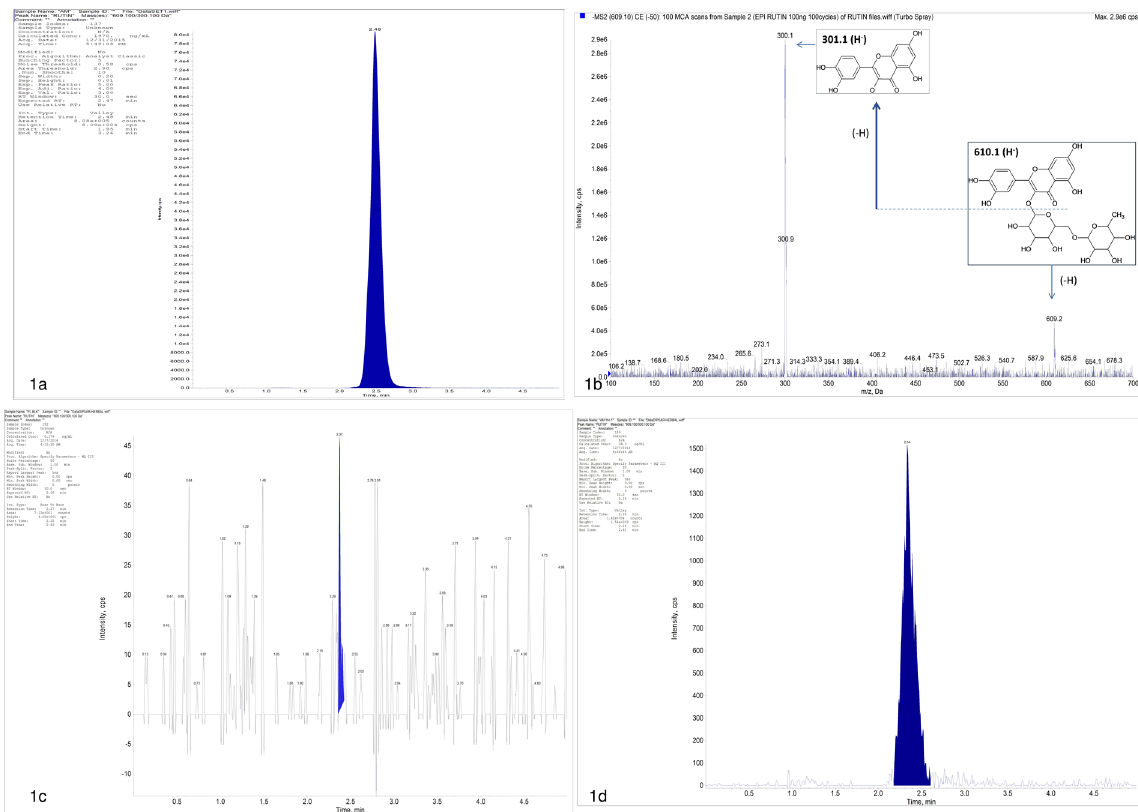
Figure 1. Schematic fragment ion intensity chromatogram of Rutin (Ru), its quantification in AM-HM and plasma using LC-MS/MS. Chromatogram of Ru present in hydro-alcoholic extract of leaves of Aegle marmelos (AM-HM,1 mg/ml) and standard Ru used for MS2 fragmentation ( a , b ). Representative chromatogram of blank human plasma wherein no peak of Ru could be detected ( c ). Well separated, finely resolved, sharp peak of Ru could be detected at 1 h time point ( d ) in plasma following administration of AM-HM (500 mg/kg, po) to normal